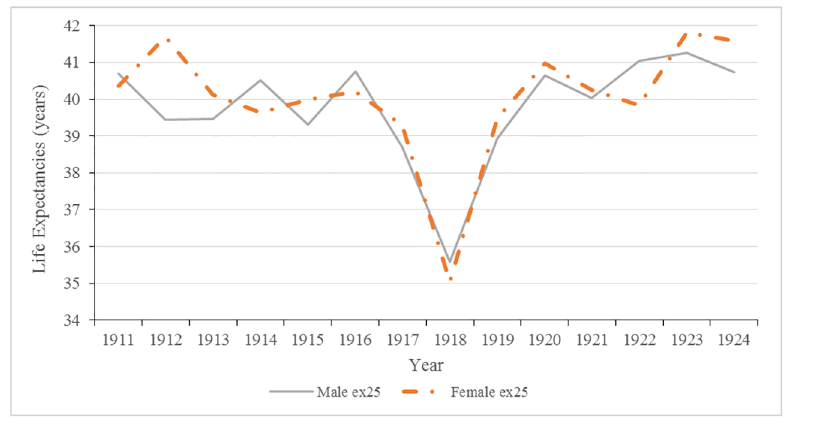
Fig 2. Male and female life expectancyat 25 yearsof age: Malta 1911to 1924.